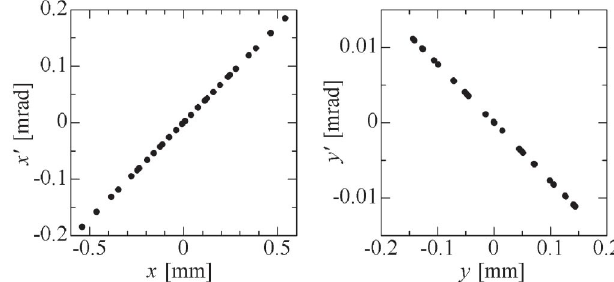
FIG. 2. Phase-space configuration of the double-shell crystal- line beam in Fig. 1. The linear distribution is maintained all around the storage ring, although the tilt angle changes periodi- =ds (cid:5) =D . If the focusing cally according to the function (cid:3) dD x (cid:3) y (cid:5) x (cid:3) y (cid:5) force is uniform along the orbit, all particles are aligned on the x 0 (cid:2) 0 and y 0 (cid:2) 0 axes (thus, W (cid:2) 0 ) and never